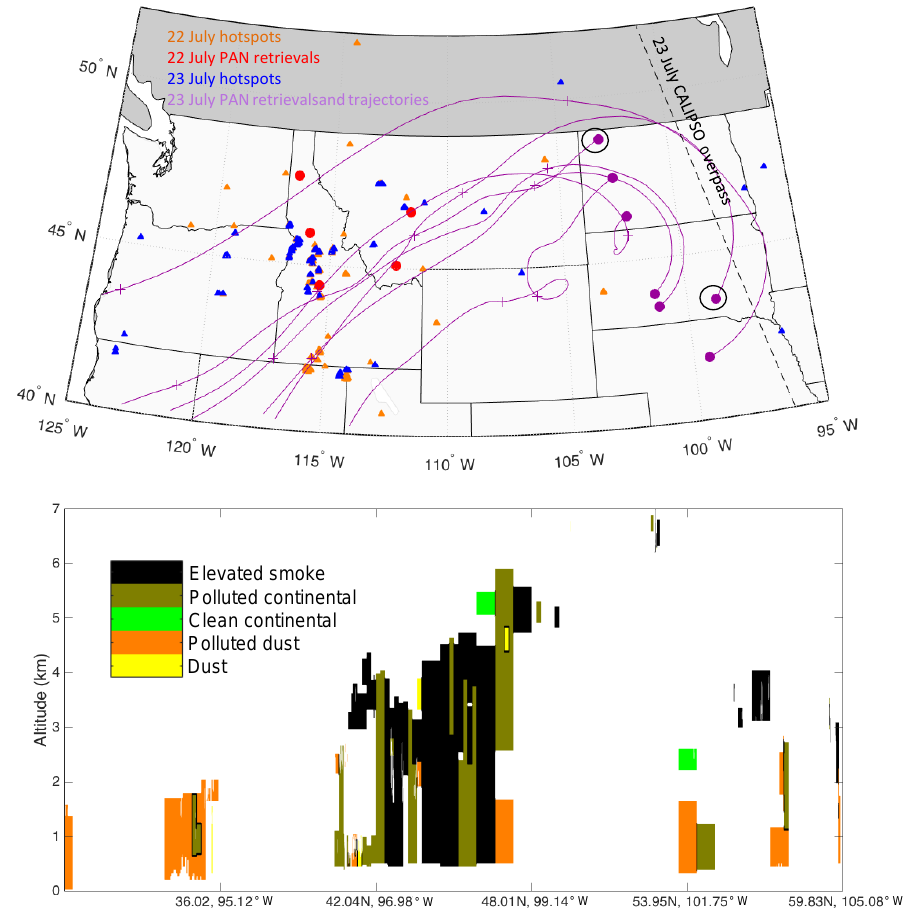
Figure 7. Top panel: case study of TES PAN retrievals overlapping HMS smoke polygons 22–23 July 2007. Orange triangles represent FIRMS MODIS hotspots for 22 July (Product MCD14ML; https://earthdata.nasa.gov/earth-observation-data/near-real-time/firms). Blue tri- angles represent FIRMS MODIS hotspots for 23 July. Red circles indicate TES PAN retrievals on 22 July, and purple circles represent TES PAN retrievals on 23 July. We have circled the two retrievals in this set with 510hPa CO greater than 150ppbv. The PAN enhancement ratios for these points are noted in Fig. 7. The purple lines signify 5 day HYSPLIT backward trajectories initialized at each TES retrieval at 4km. The purple “ + ” signifies 24h of transport time on the 4km trajectories. The black dashed line shows the location of the CALIPSO swath shown in the lower panel. Lower panel: CALIPSO aerosol subtype observed on 23 July 2007. CALIPSO Science Team (2016), CALIPSO/CALIOP Level 2, Vertical Feature Mask Data, version 4.10, Hampton, VA, USA: NASA Atmospheric Science Data Center (ASDC), accessed by Emily V. Fischer at